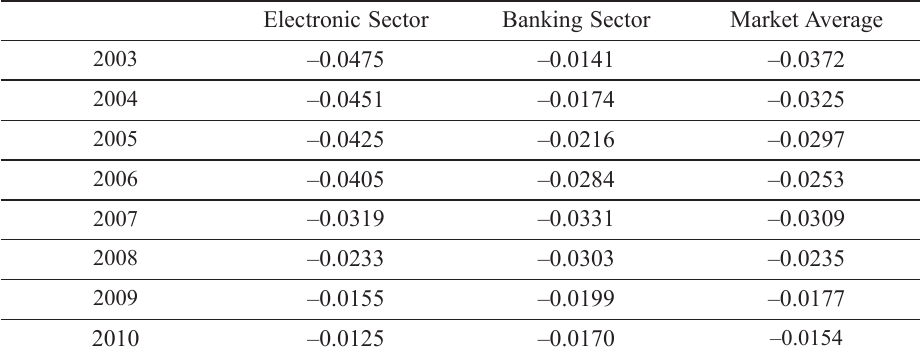
Table 6. Time series  CoVaR of Electronic Sector, Banking